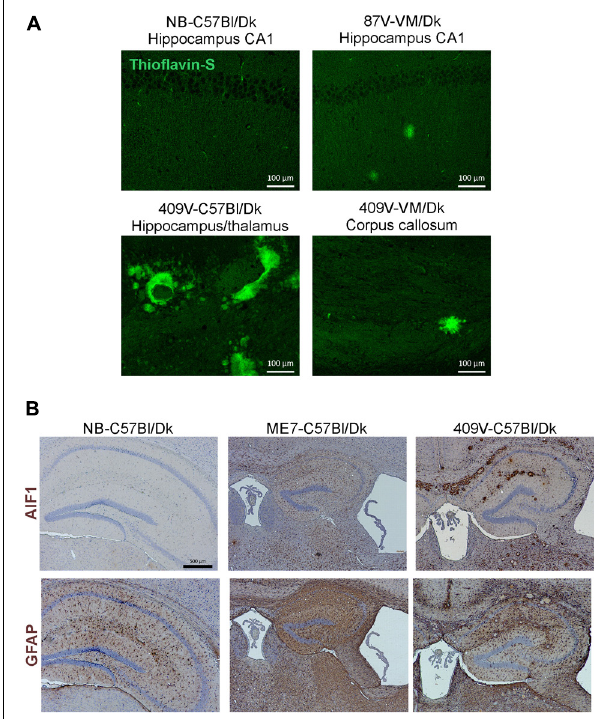
FIGURE 5 | Histopathological detection of amyloid and activated glial cells in the brain following prion infection. (A) Thioflavin-S staining of normal brain C57Bl/Dk, 87V-VM/Dk, 409V-C57Bl/Dk and 409V-VM/Dk prion agent strain and host combinations revealed characteristic amyloid deposits in the brains of mice with amyloidal PrP accumulations. Images are representative of N = 4 mice/group. Scale bars = 100 µ m. (B) Immunohistochemical detection of microglia (AIF1 + cells, upper row) and astrocytes (GFAP + cells, lower row). This analysis showed minimal AIF1 + and GFAP + immunostaining in the brains of uninfected control mice, whereas expression of these markers was strongly upregulated in brains of mice with terminal prion disease. Representative images N = 6 mice/group are shown. Scale bars = 500 µ